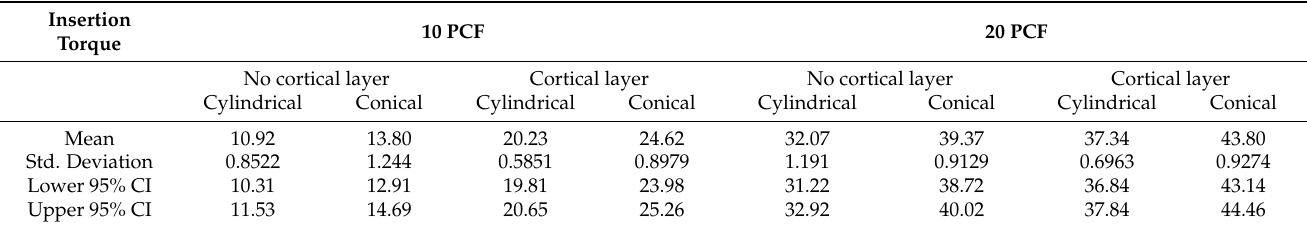
Table 1. Summary of insertion torque (IT) values of the tested cylindrical and conical implants.